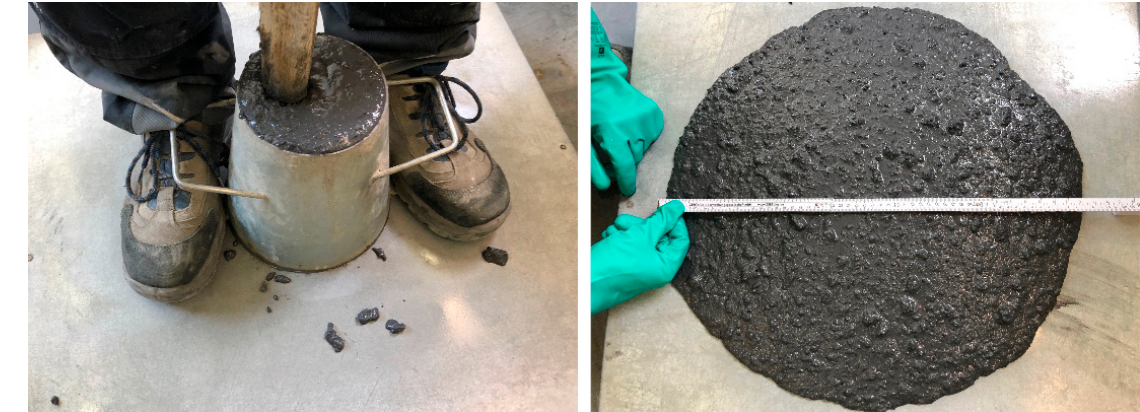
Figure 3. G50M33R17 ‐ 11 during workability test. Figure 3. G50M33R17-11 during workability